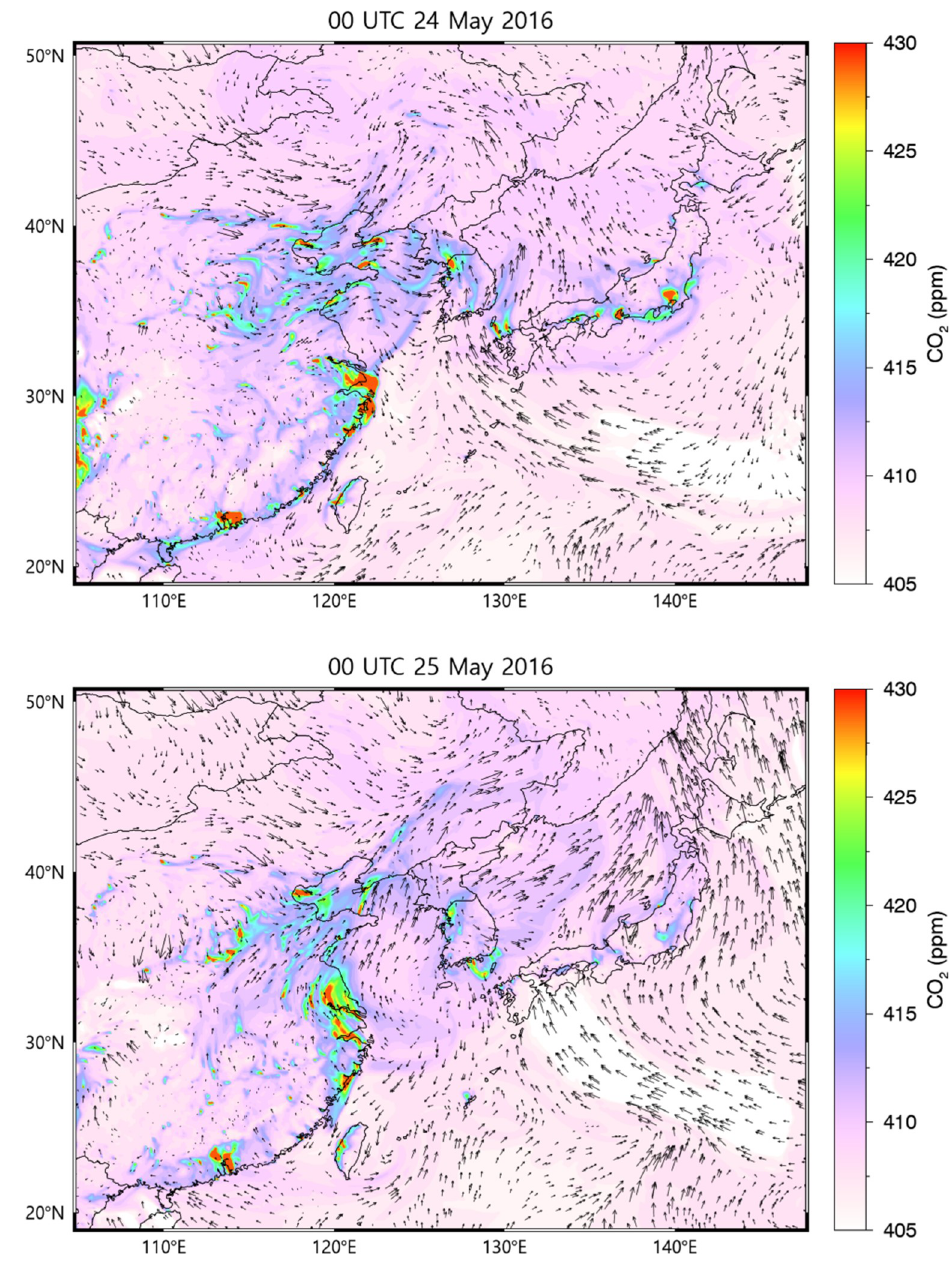
Fig 8. Spatiotemporal variations of CO 2 concentrations over the coarse domain at the ground level on May 24 (upper panel) and 25 (bottom panel) at 09:00 LST. The simulated results were comparable with the ground CO two CO monitoring sites, GO (MB ~ -0.4 ppm) and UL (MB ~ -0.7 ppm), and with the CO 2 column concentration from the TCCON spectrometer at AN (MB ~ -0.3 ppm). Beside the monitoring sites, we also compared simulations with tower observations at BO. The model sig- nificantly underestimated the concentration at 60 m at night and the vertical gradient of CO